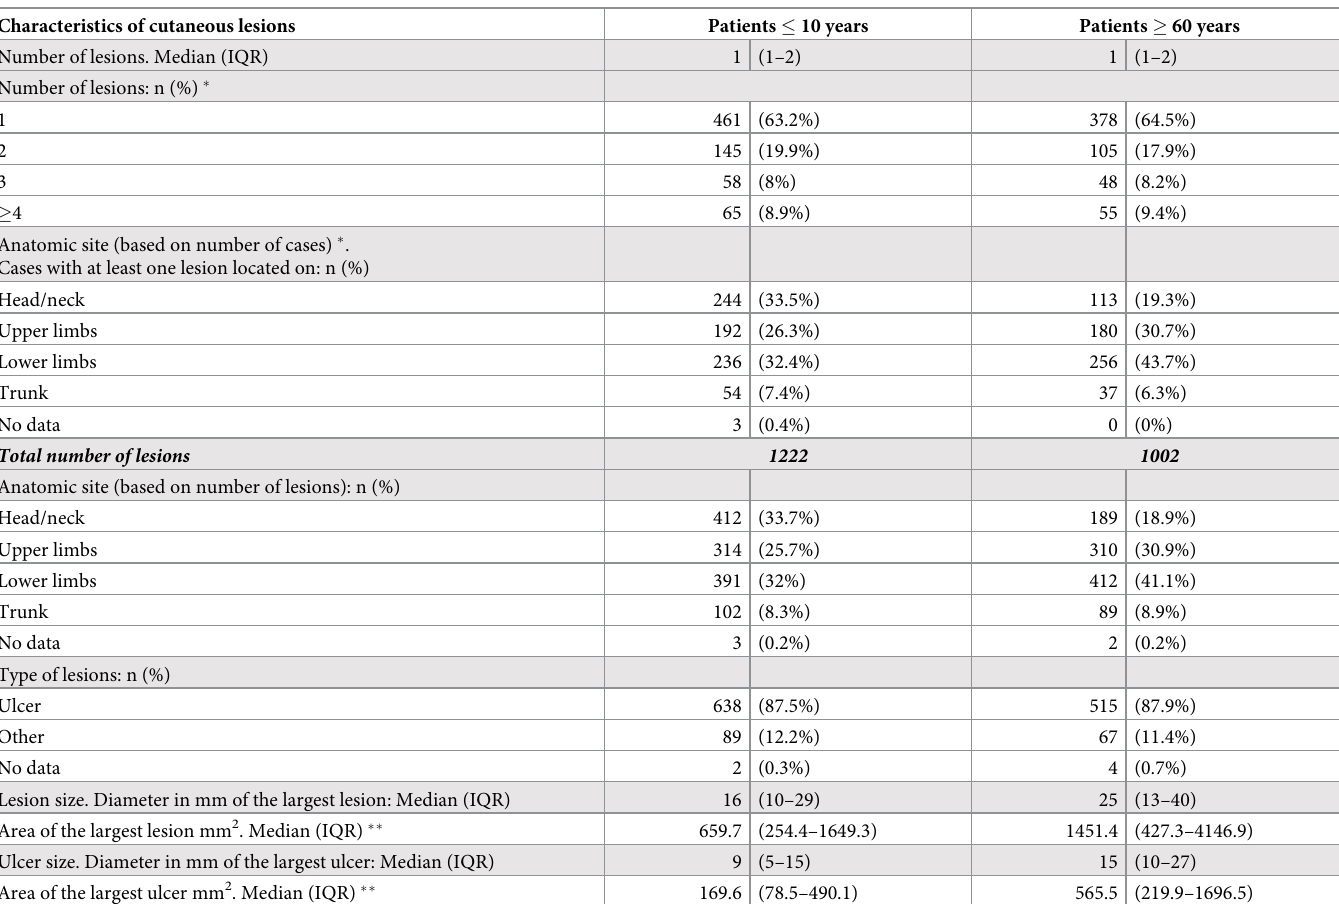
Table 2. Characteristics of cutaneous